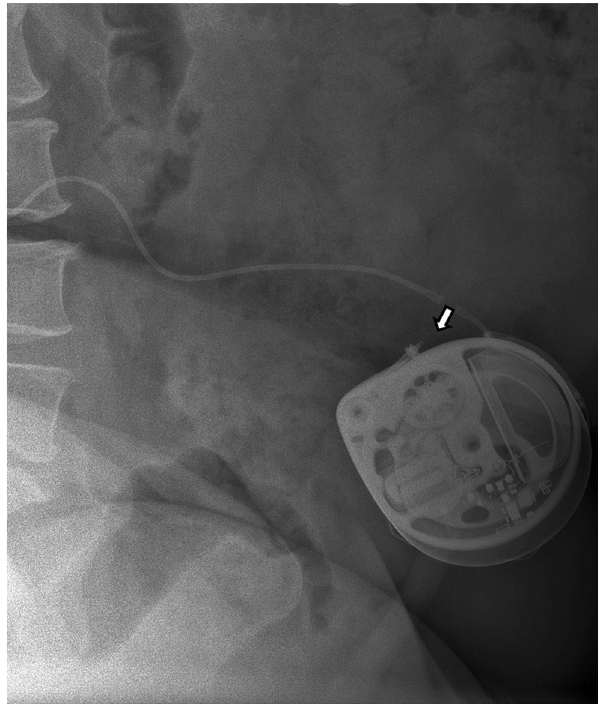
Fig. 5 Disconnection at the pump-catheter site ( white arrow ) with signs of withdrawal syndrome in a 52-year-old woman with dystonia in complex regional pain